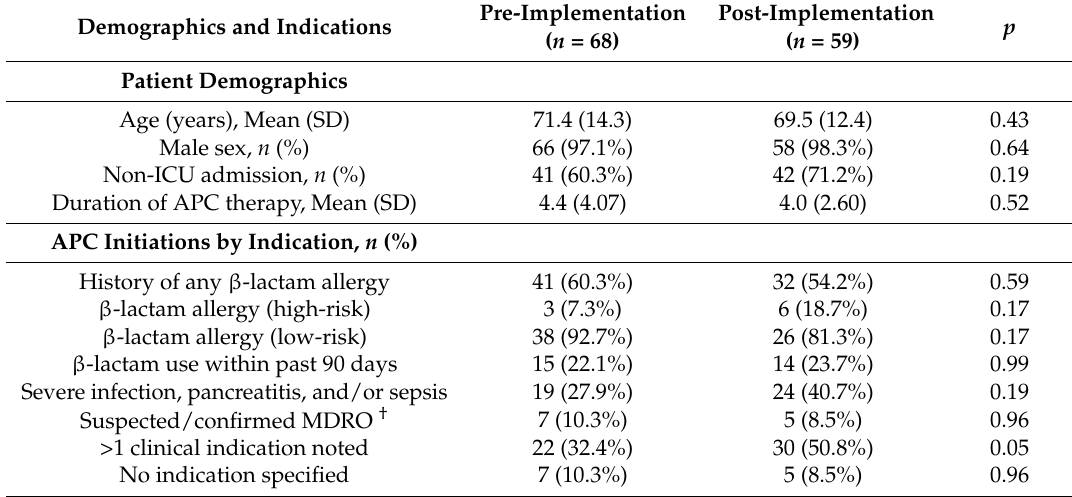
Table 1. Patient Demographics and Indications for Antipseudomonal Carbapenem (APC) Use.